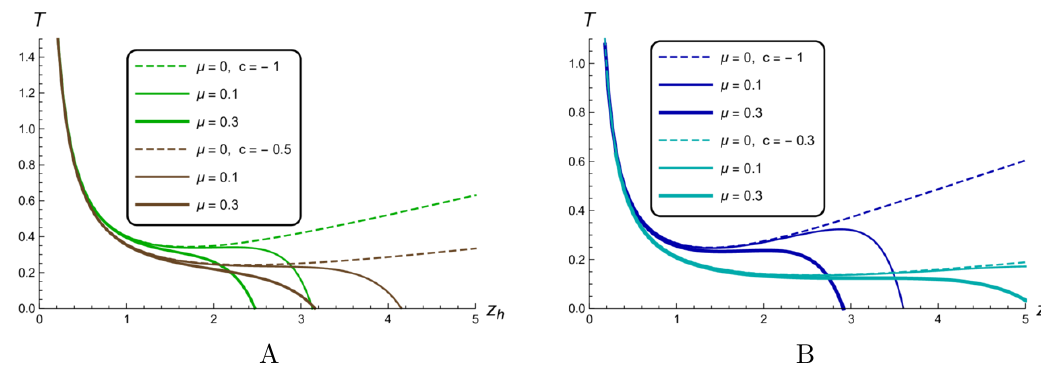
Figure 19 . File: Termo-mu-c-zh-original.nb+. The dependence of temperature T ( z h ; (cid:22); c; (cid:23) ) on z h for di(cid:11)erent c and (cid:22) in isotropic (A) and anisotropic, (cid:23) = 4 : 5, (B) cases.